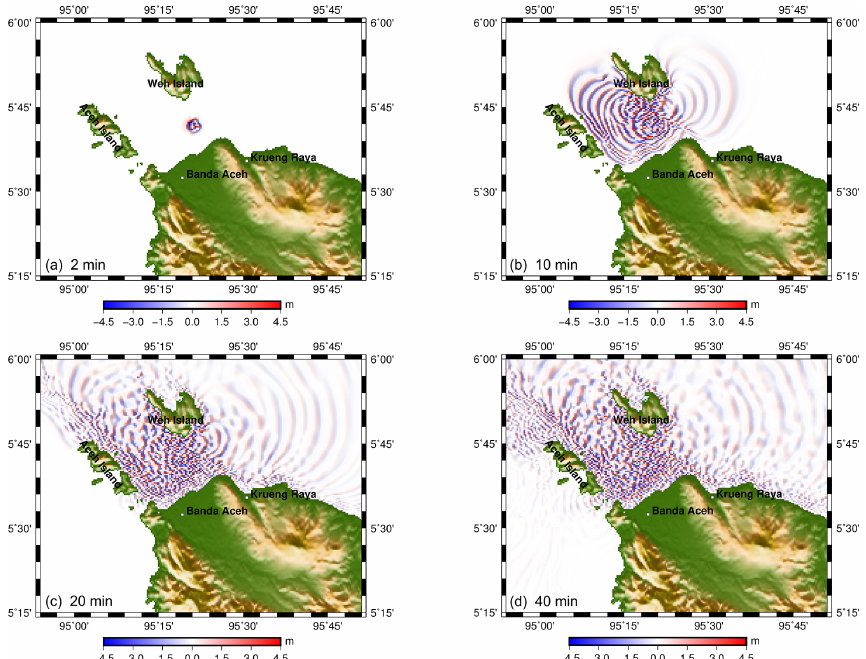
Figure 8. Snapshots of a tsunami wave from a submarine landslide source at location 4 of Fig. 6c at propagation times of (a) 2min, (b) 10min, (c) 20min and (d)